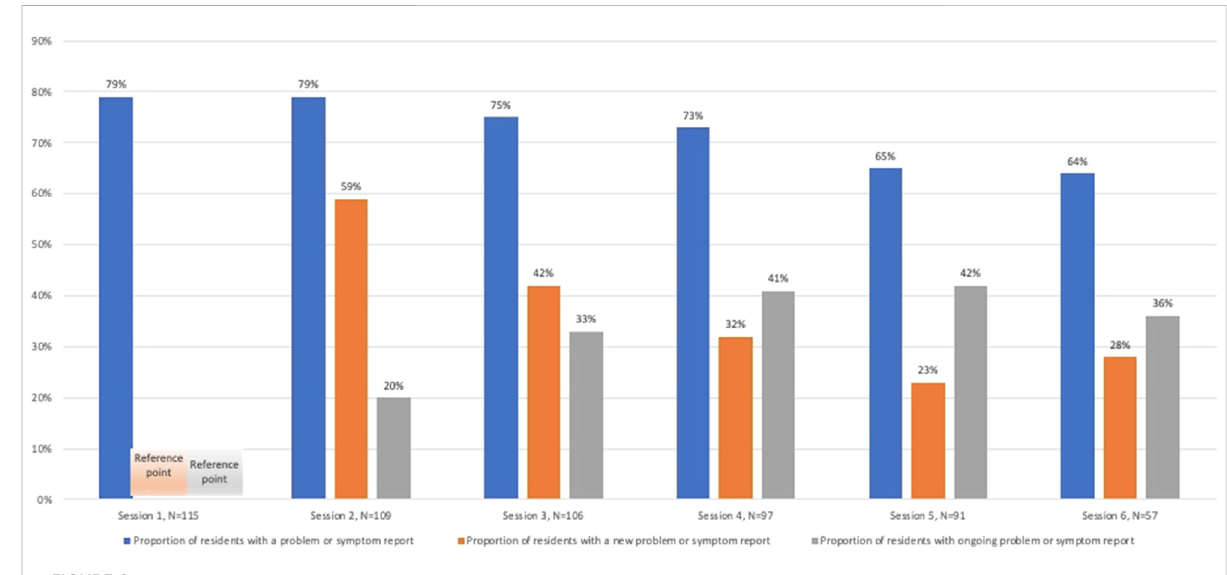
FIGURE 2 Proportion of residents with new and ongoing medicine-related problems or symptoms at each session.